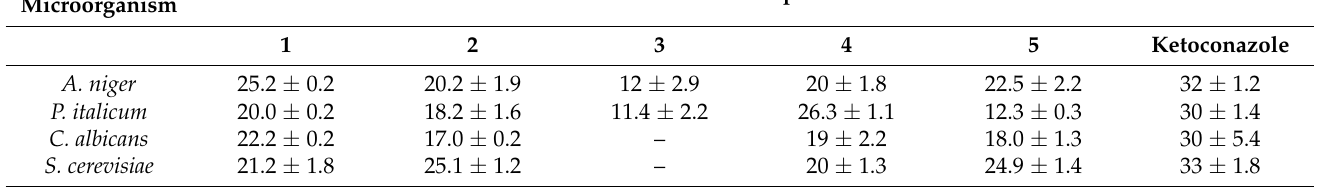
Table 4. Antifungal activity of five sufficient compounds isolated from the roots of Taiwania cryptome- rioides (diameter of the zone of growth inhibition fungicidal zone in mm, including the diameter of the disc, 8 mm).